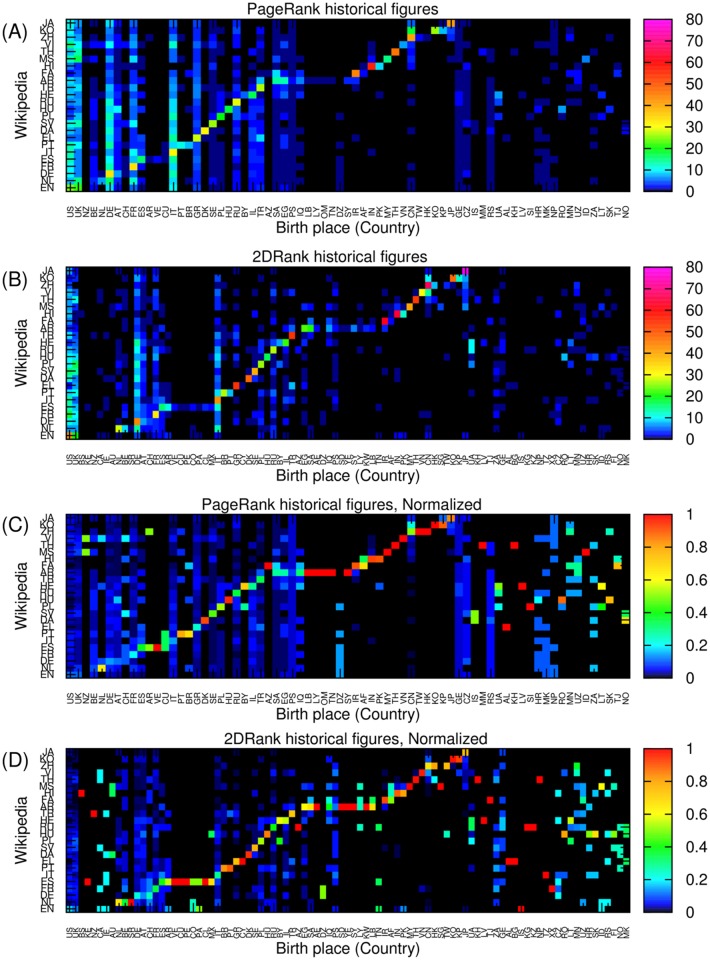
Birth place distributions over countries of top historical figures from each Wikipedia edition; two letter country codes are represented in Table 3.Panels: (A) distributions of PageRank historical figures over 71 countries for each Wikipedia edition; (B) distributions of 2DRank historical figures over 91 countries for each Wikipedia edition; (C) column normalized birth place distributions of PageRank historical figures of panel (A); (D) column normalized birth place distributions of 2DRank historical figures of panel (B).